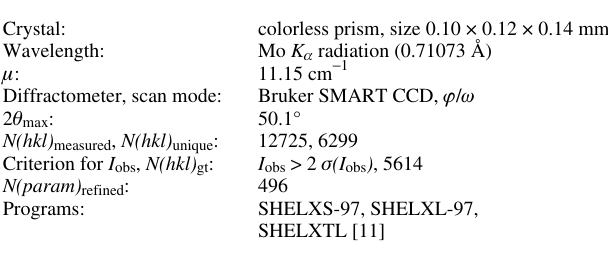
Table 1. Data collection and handling.